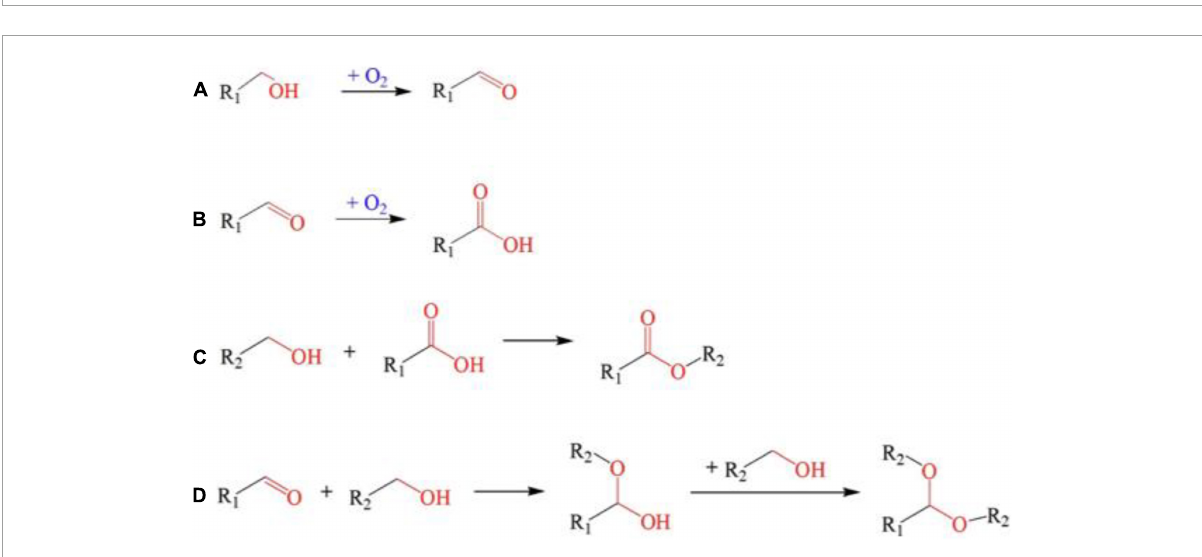
FIGURE5 The reactions promoted by PEF treatment. (A) Alcohols oxidized into aldehydes; (B) aldehydes oxidized to acids; (C) Esterification reaction; (D) Polymerization reaction of alcohols and aldehydes could condensate into acetal. Reprinted from Ma et al. (97).